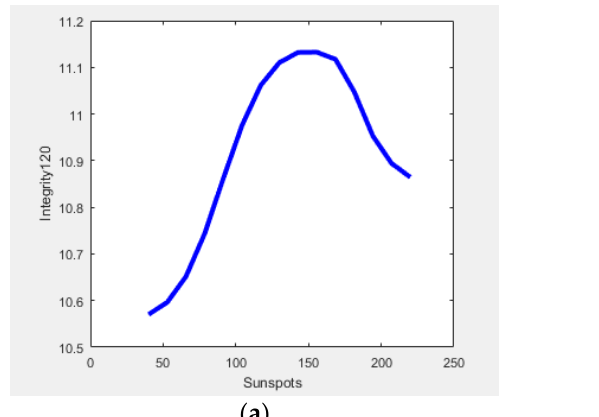
Figure 7. The influence of the sunspots ( x 1 ) on the integrity of PRN120 ( a ) and PRN126 ( b ) (Own study in MATLAB Fuzzy Logic Toolbox).